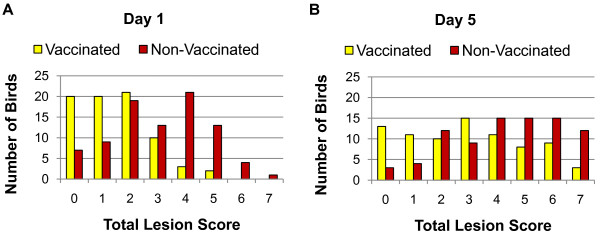
Total lesion score distribution. Comparison of the distribution of lesion scores of challenged birds taken on day 1 between birds that received the vaccine and birds that did not receive the vaccine for all 4 replicates on (a) day 1 and (b) day 5 (P < 0.001).